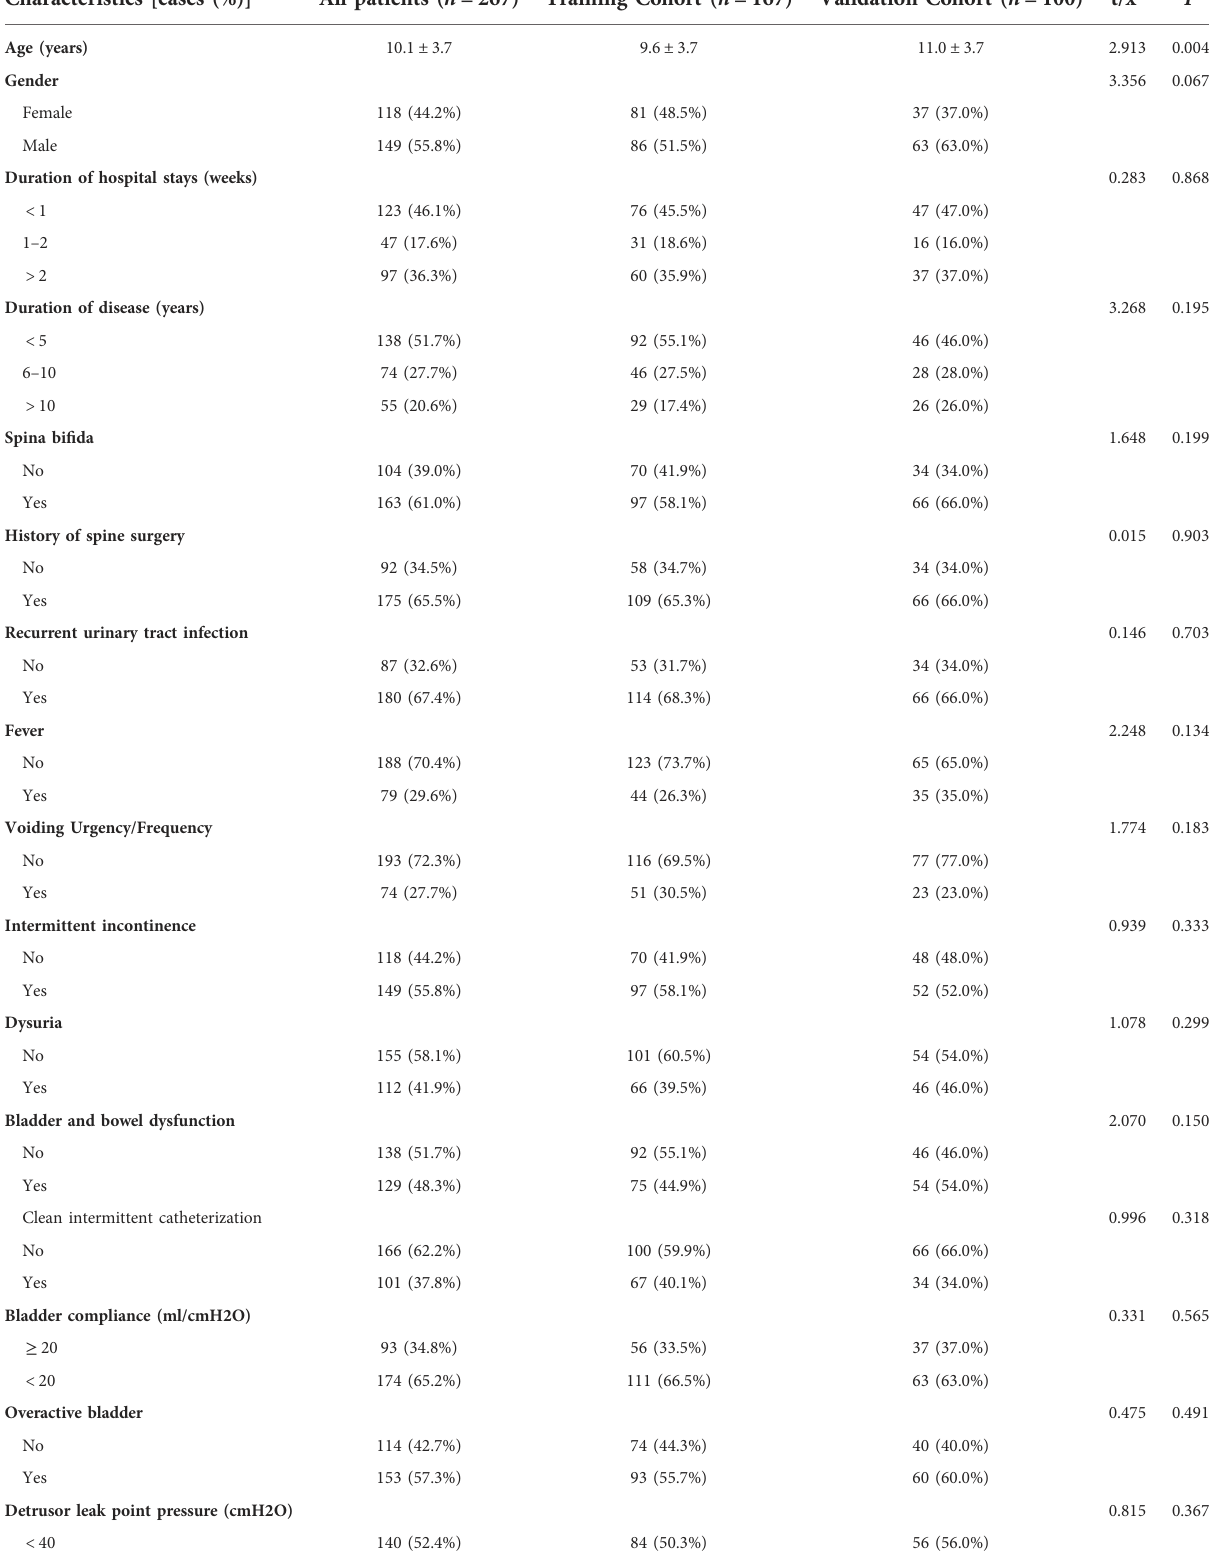
TABLE 1 Demographic and clinical features of patients in the training and validation